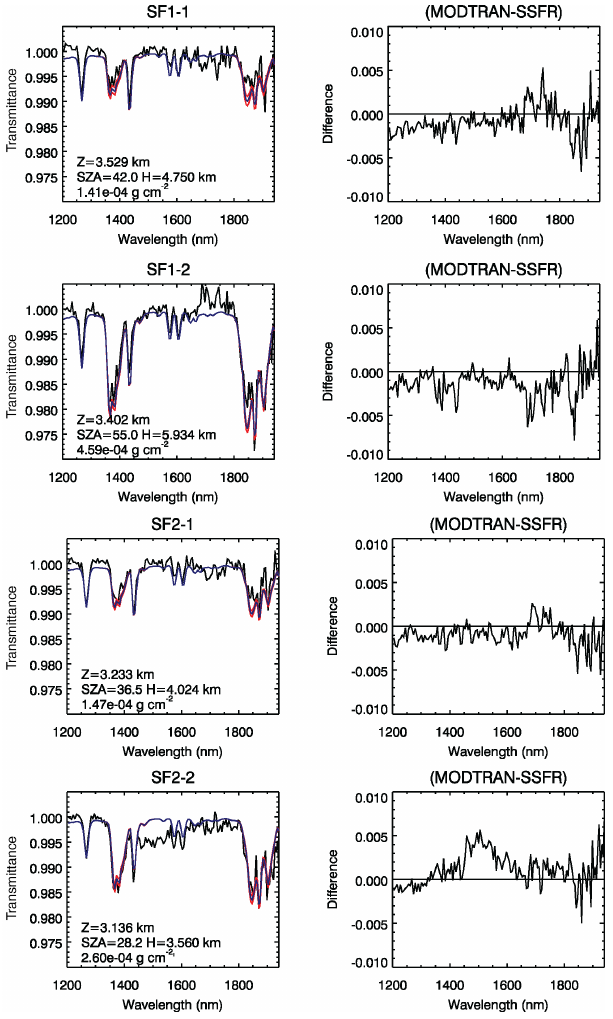
Figure 6. (left) Measured (black) and modeled (blue) transmit- tances for vertical profiles during the first and second ATTREX science flights are plotted. The red traces show plus and minus 1 standard deviation of the measured transmittance. (right) Differ- ence between the measured and modeled transmittances. The ver- tical profile distance Z , the solar zenith angle SZA, the absorption path length H , and the integrated water vapor amounts are given in the left-hand plots.